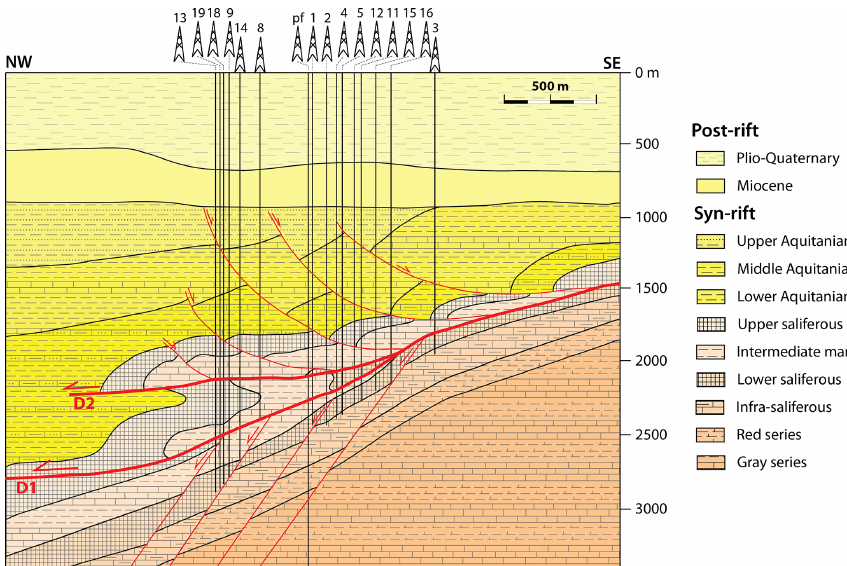
Figure 1. Geological structural scheme of area under study crossing the numbered wells (Derrick symbols at the surface, pf is for Pierrefeu well) at Vauvert (from Valette and Benedicto, 1995). D1 and D2 represent the two decollements (thrust fault) affecting the salt